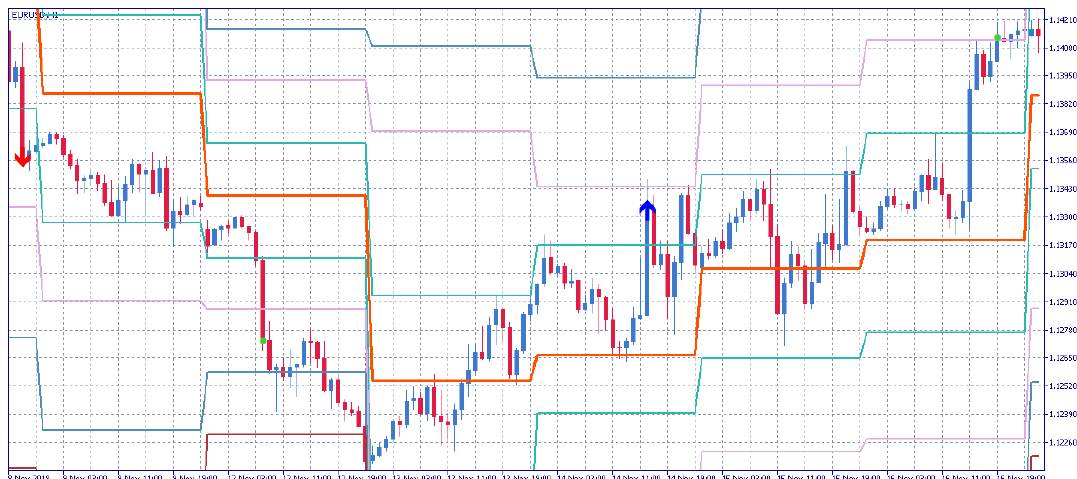
Figure A7. EUR/USD chart with signals from the AdParSAR strategy